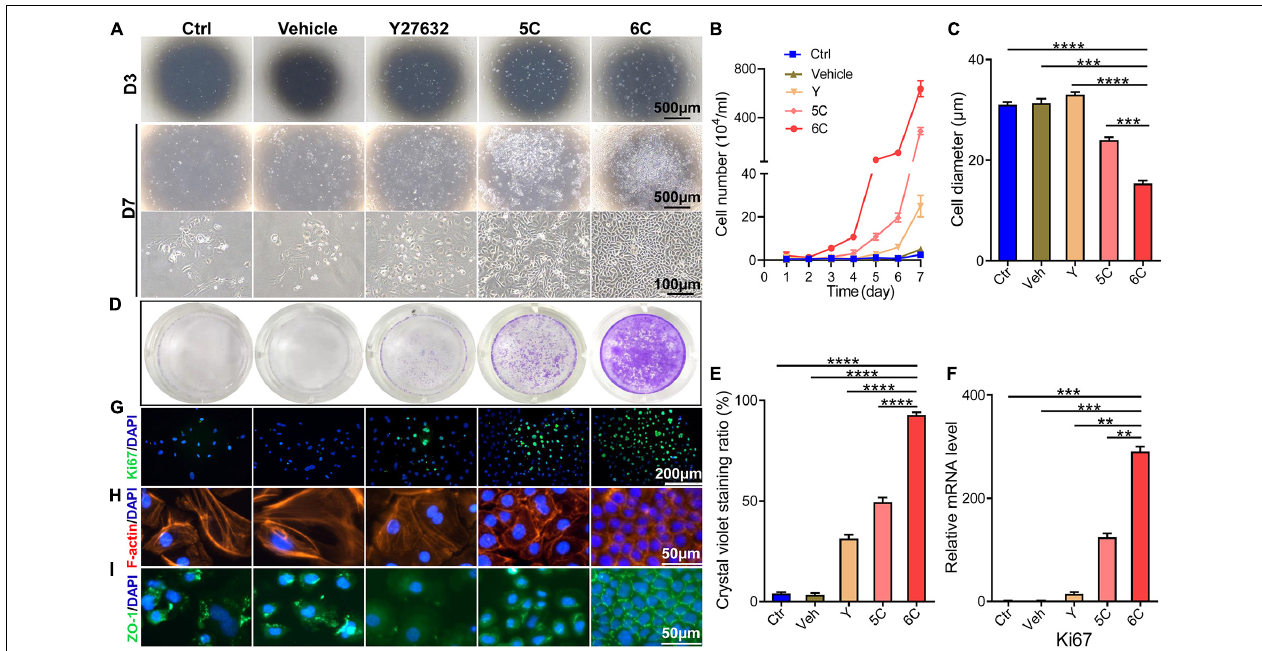
FIGURE 1 | 6C can promote the proliferation of primary mCEC. (A) Morphological comparison of mCEC cultured with different compositions. Images were taken at day 3 and day 7 post seeding. (B) Cell growth curve. (C) A statistical graph of the average diameter of the cells after 1 week of culture. (D) Crystal violet staining results after 1 week of cell culture. 6C group had the most stained area. (E) Statistical analysis of crystal violet staining results after 1 week of cell culture. ( n = 5 biological replicates). (F) qRT-PCR analysis of Ki67 gene expression (normalized to ctrl). (G) Ki67 (green) immunofluorescence staining. Nuclei were stained with DAPI (blue). (H,I) Immunofluorescence staining of F-actin (red) and ZO-1 (green). Nuclei were stained with DAPI (blue). The expression of F-actin and ZO-1 in 6C group was distributed on the cell membrane, and the connection between cells was tight, but the distribution of other treatment groups was scattered or missing. Data expressed as the means ± SEM from three separate experiments (** P < 0.01, *** P < 0.001, **** P <